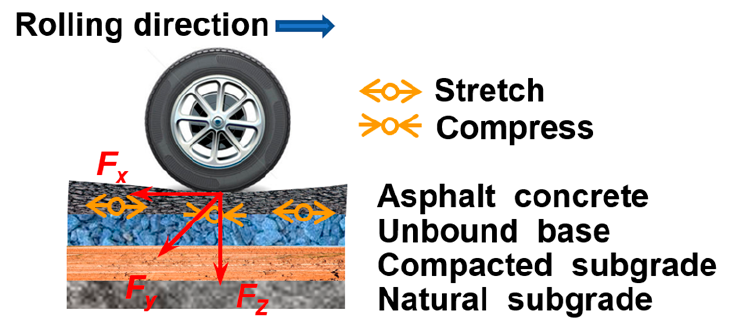
Figure 1. Schematic diagram of tire–pavement interaction.